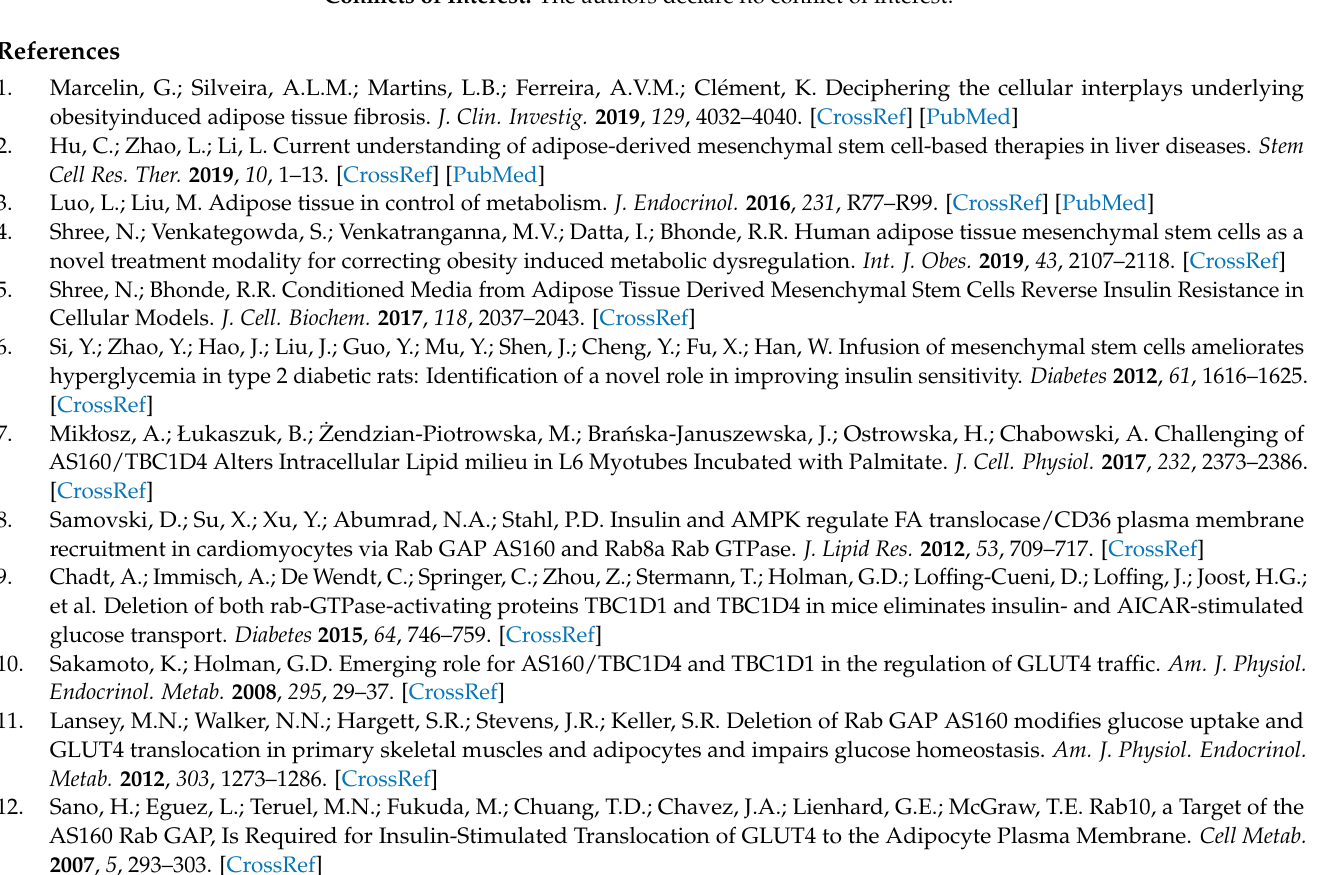
.3390/cells10061515/s1, Figure S1. Gating strategy for ADMSCs stem cells derived from visceral and subcutaneous adipose tissues. Figure S2. Surface markers of ADMSCs determined by flow cytometry. Figure S3. Adipogenic (a), osteogenic (b) and chondrogenic (c) differentiation of ADMSCs, Figure S4. FABP4 mRNA (A) and protein (B) abundance in TBC1D1 and/or TBC1D4 deficient adipocytes. Figure S5. Intracellular localization of RabGTPase-activating proteins (TBC1D1 and TBC1D4) and FA transporters (CD36/SR-B2, FABPpm) in the adipocytes differentiated from (A) sub- and (B) visADMSCs was analyzed by the means of confocal microscopy. Table S1. The anthropometric and clinical characteristics of